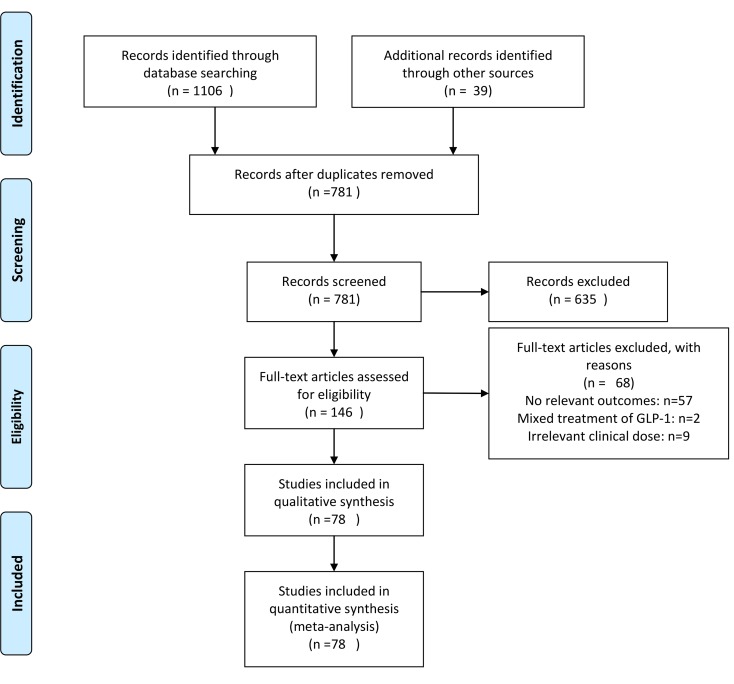
Flow chart of studies considered for inclusion, RCT = randomized controlled trial.This Flow chart is based on PRISMA 2009 Flow Diagram[30].